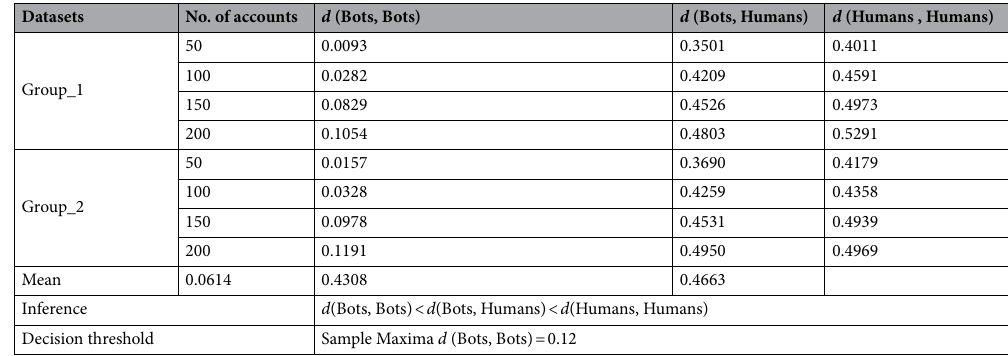
Table 2. Analysis conducted to set decision threshold in Group_1 and